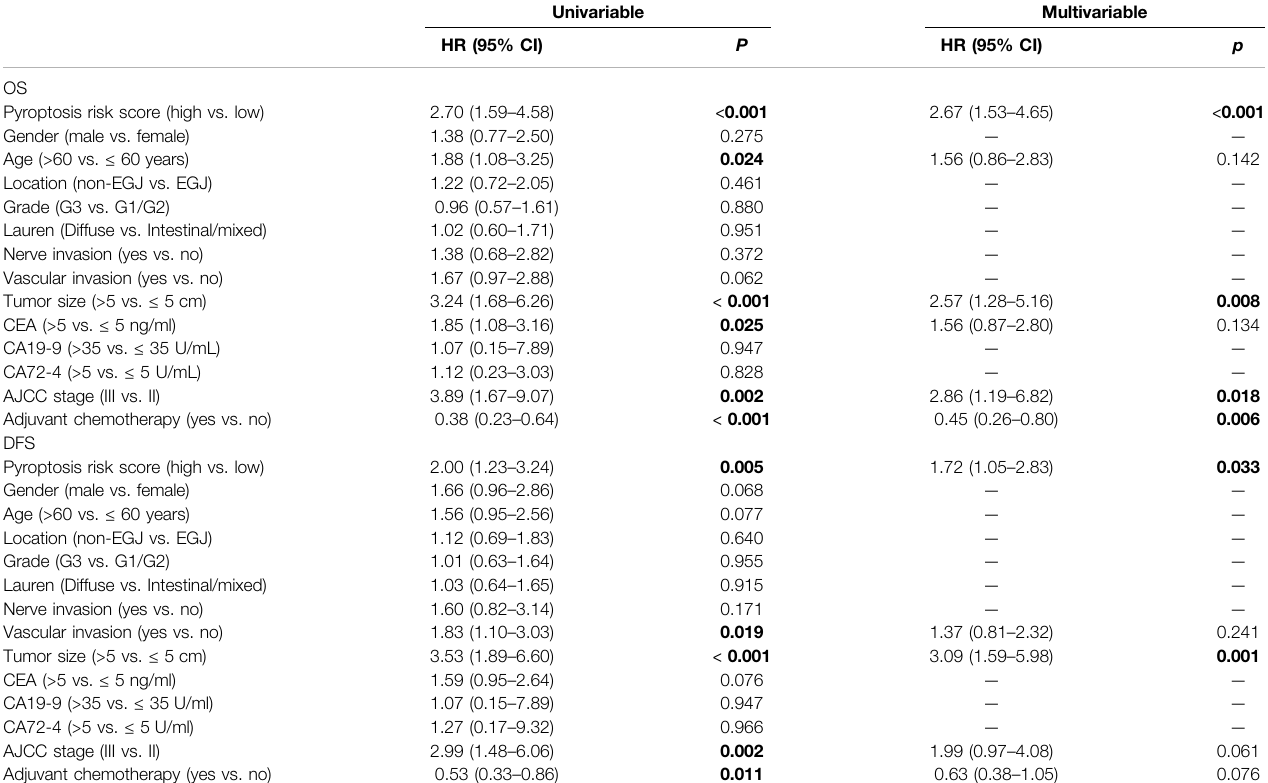
TABLE 2 | Uni- and multivariable Cox regression of OS and DFS in the SYSUCC cohort. Univariable